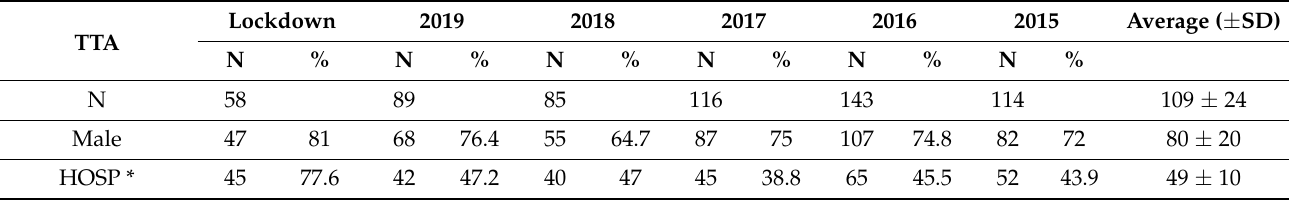
Table 2. The utilization of trauma team resources and outcomes of the injured patients presented